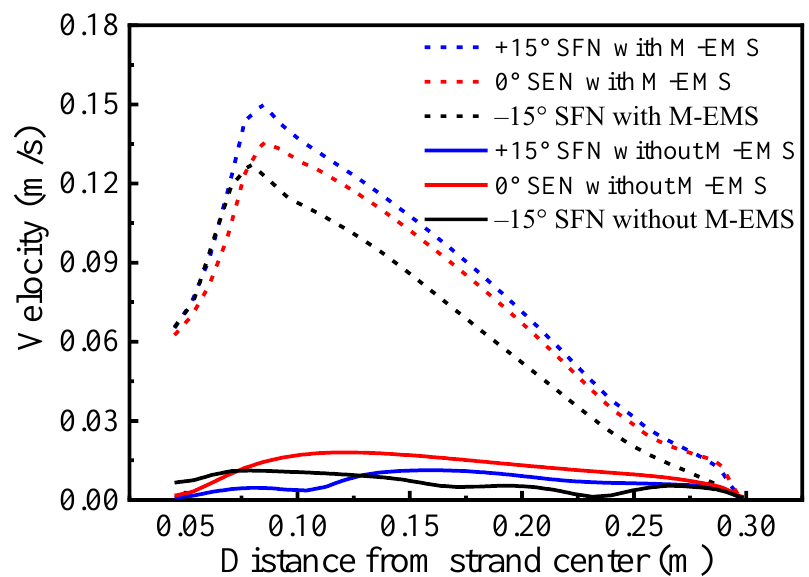
Figure 17. Tangential velocity distributions along the centerline of the meniscus.